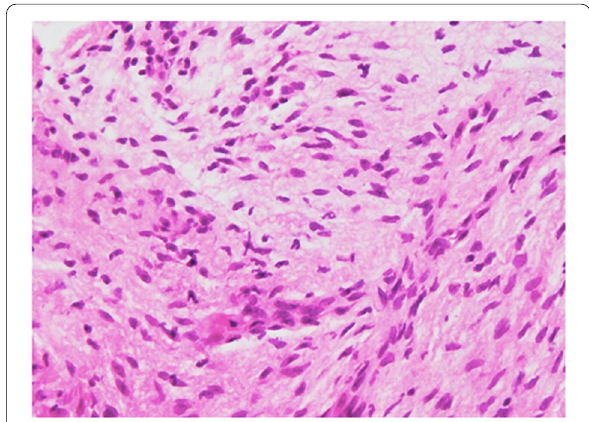
Fig. 4 The spindle shaped cells showed normochromic nuclei with inconspicuous nucleoli and indistinct eosinophilic cytoplasm. No nuclear pleomorphism, mitosis, or tumor necrosis were observed (hematoxylin and eosin stain, original magnification